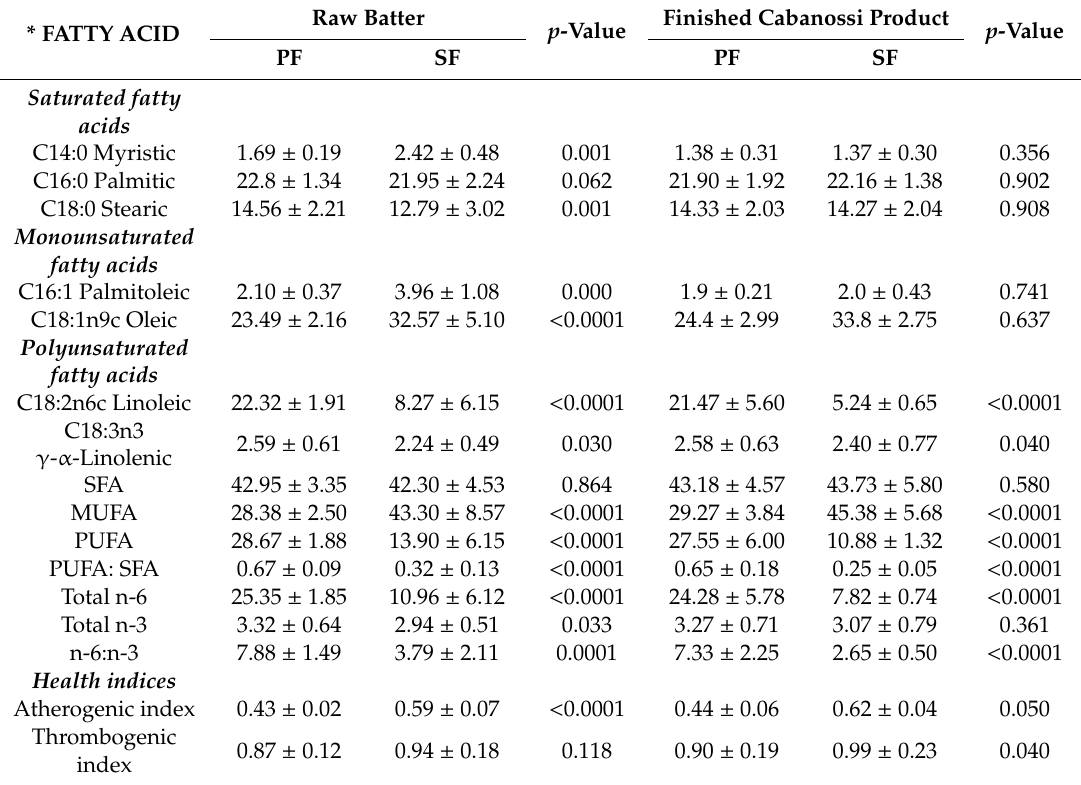
Table 4. Percentage fatty acid composition of cabanossi made with either pork backfat (PF) or sheep tail / backfat (SF) before and after